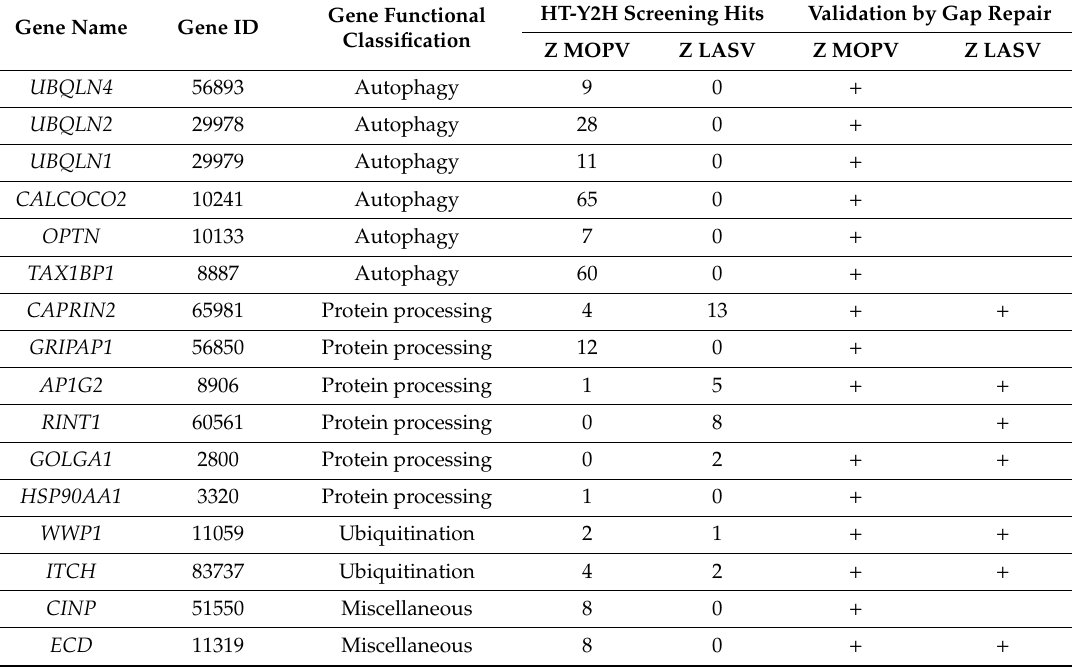
Table 1. Host protein interactors with Lassa virus (LASV) and Mopeia virus (MOPV) Z proteins identified by yeast two-hybrid (Y2H) and validated by gap